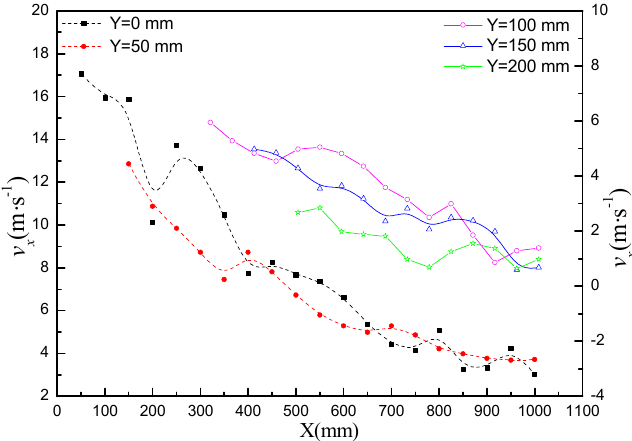
Figure 8. Comparison curve of the radial velocity along the axial direction.